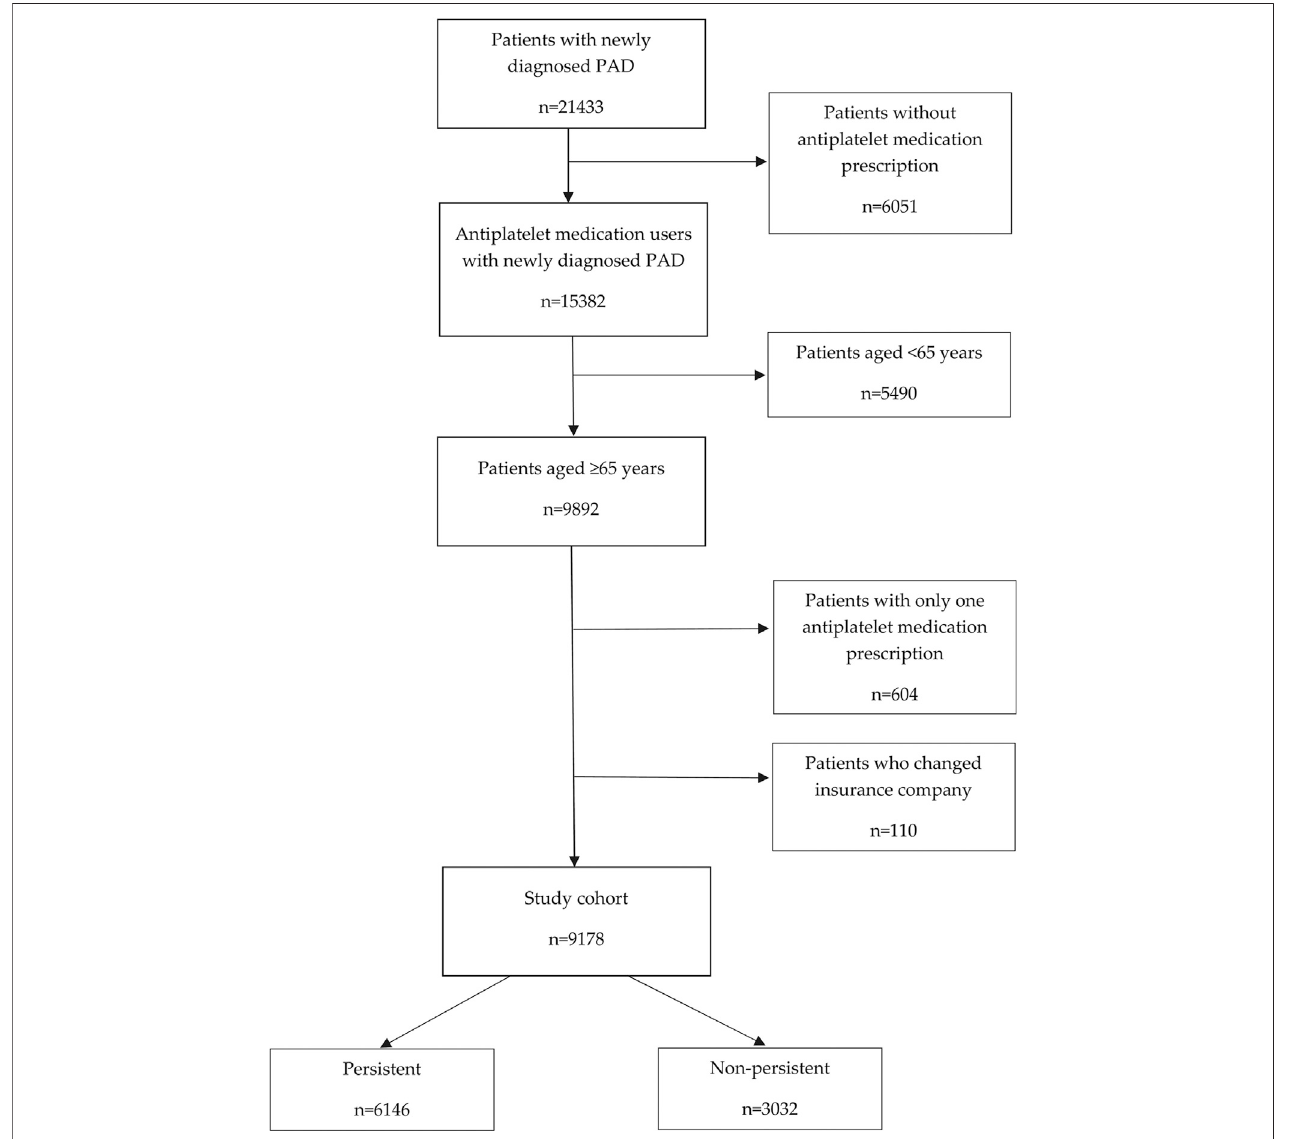
FIGURE 1 | Flow chart of the study cohort ( n (cid:1)